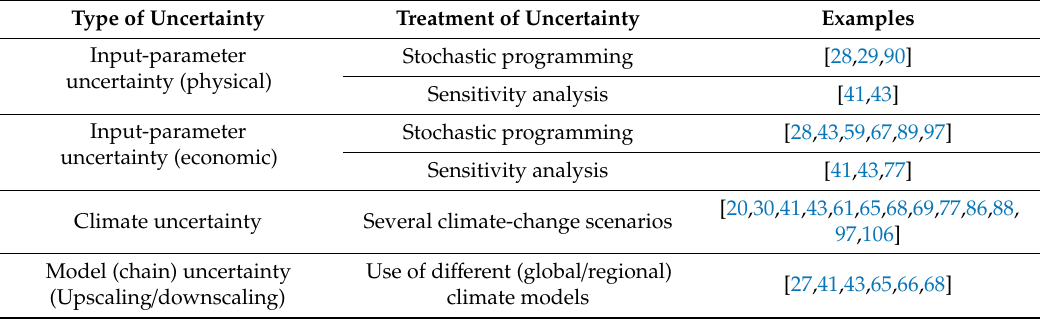
Table 2. Consideration of CC-related uncertainties and risks in